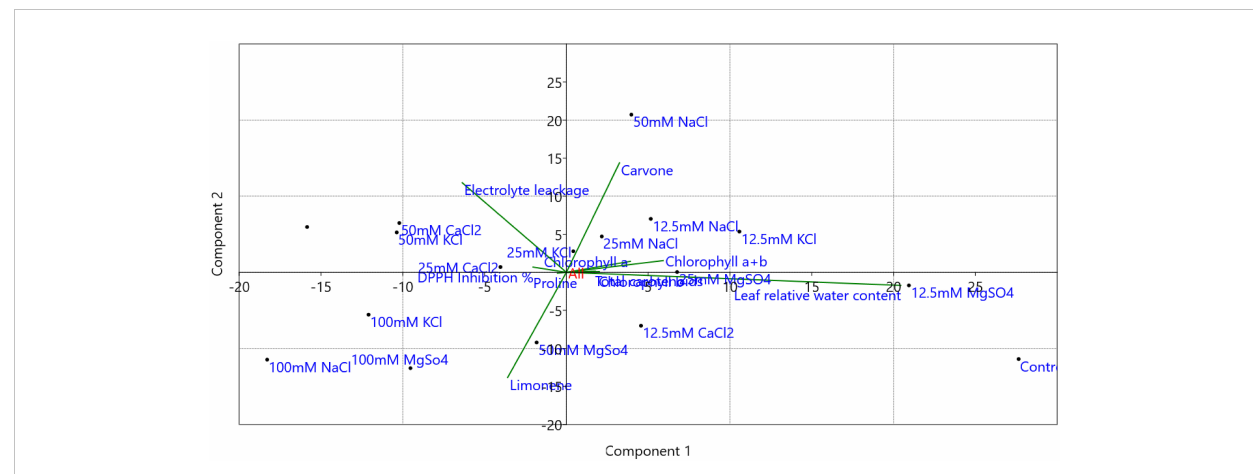
FIGURE 13 Principal component analysis (PCA) biplots of M. longifolia chlorophyll (a), chlorophyll (b), chlorophyll (a + b), total carotenoids, leaf relative water content, electrolyte leakage, proline content, DPPH inhibition %, carvone and limonene % area with different (12.5, 25, 50, and 100 mM) concentrations of NaCl, KCl, MgSO 4 , and CaCl 2 salts compared to the control